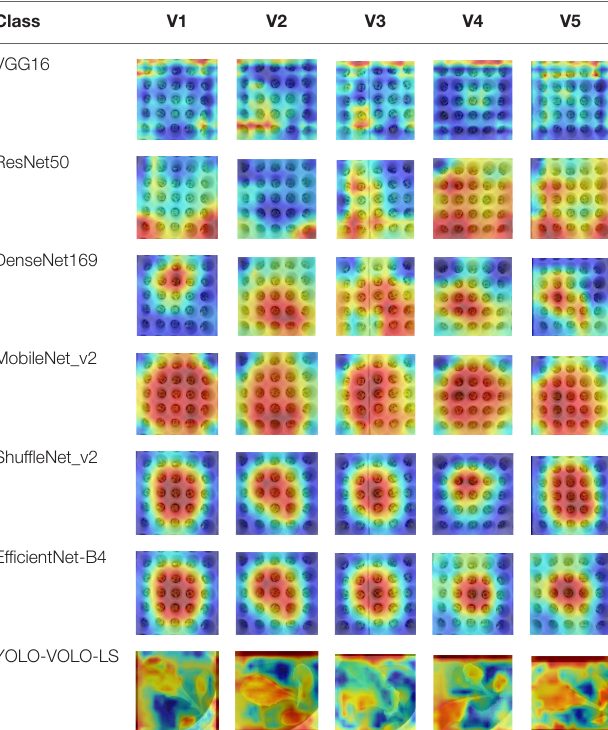
TABLE 8 | The class activation map (CAM) of different